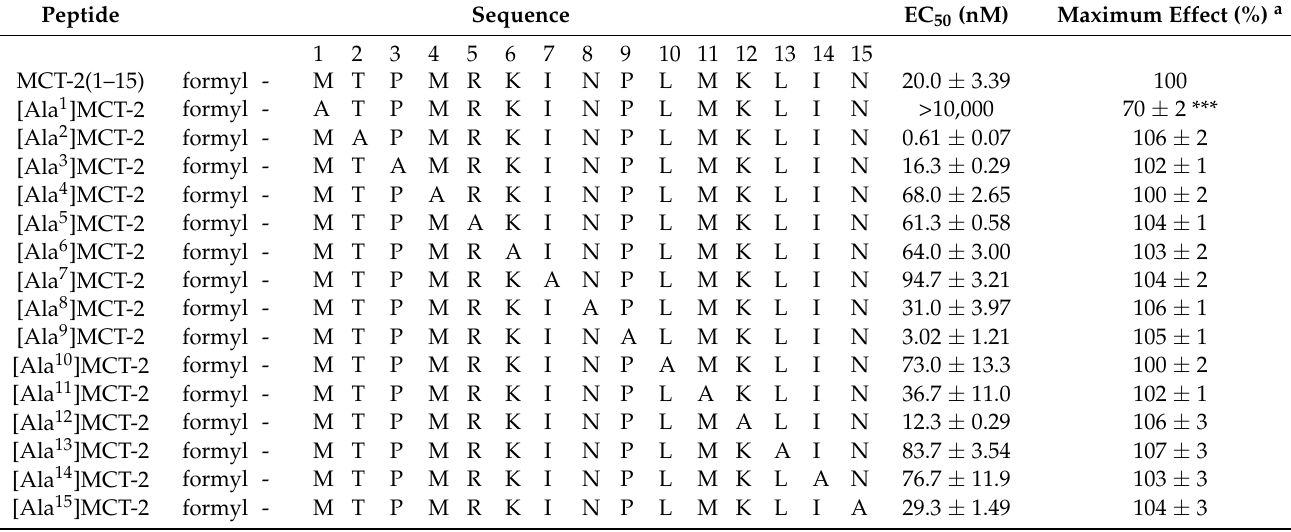
Figure 4. Effects of substituting Ala for each amino acid residue in the MCT-2(1–7) ( A ) or the MCT-2(8–15) ( B ) sequence within MCT-2(1–15) on β -hexosaminidase release by differentiated HL-60 cells. The differentiated HL-60 cells were stimulated by MCT-2(1–15) or its derivatives at 37 °C for 10 min, and the amount of the released β -hexosaminidase was quantified as described in “Materials and Methods”. The ability of each peptide to cause β -hexosaminidase release is expressed as a percentage of enzyme secretion promoted by 10 μ M MCT-2(1-15). Data are expressed as the mean ± SE of four to six independent experiments. Table 2. Amino acid sequences of MCT-2(1–15) and its Ala-substituted derivatives and their EC 50 values and maximum effects on the induction of β -hexosaminidase release from differentiated HL-60 cells.